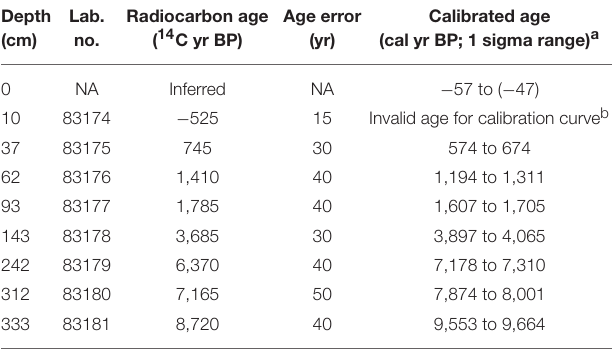
TABLE 1 | Radiocarbon and calibrated dates from M. Casanova. Depth